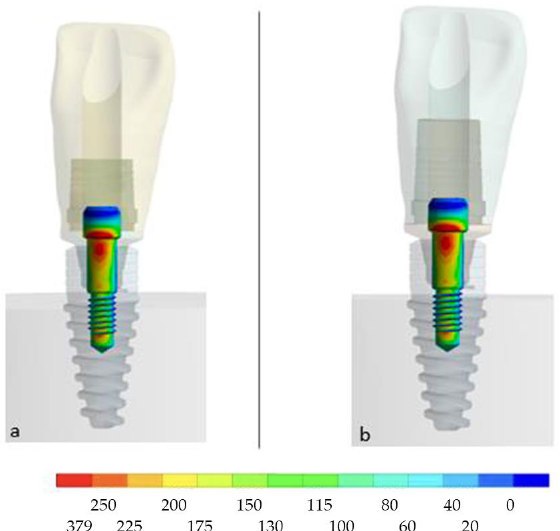
Figure 12. Stress concentration in the screw with short abutment ( a ), and long abutment ( b ).